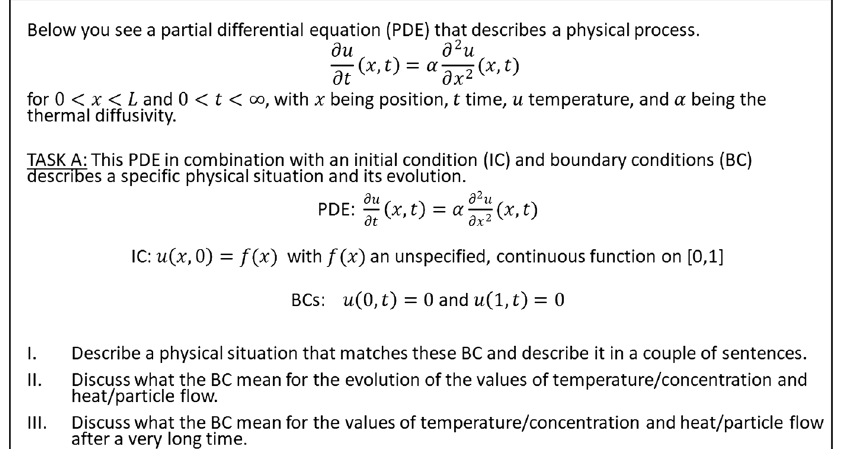
FIG. 6. Interview question: Task